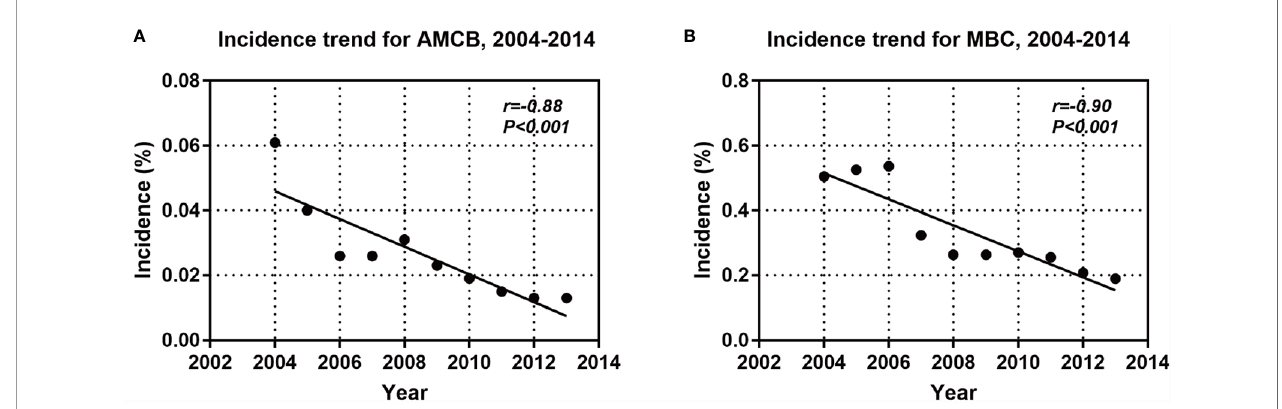
FIGURE 1 | Incidence trends for AMCB (A) and MBC (B)